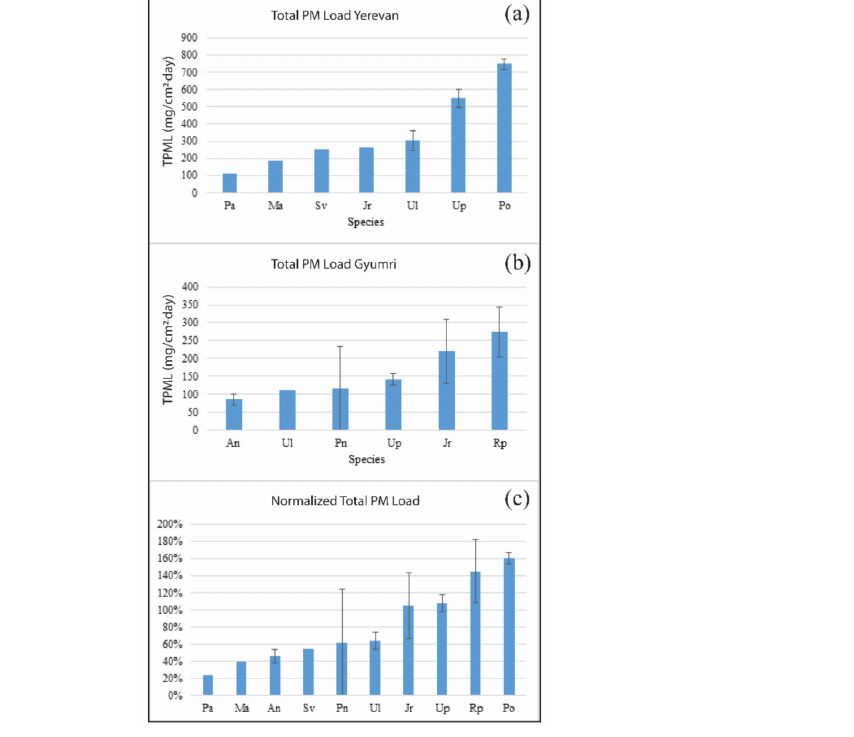
Figure 4. Average total PM load (TPML) per tree species in Yerevan ( a ) and Gyumri ( b ). The data from the two cities, properly normalized by the city average TPML, are averaged and combined in panel ( c ). Error bars represent standard